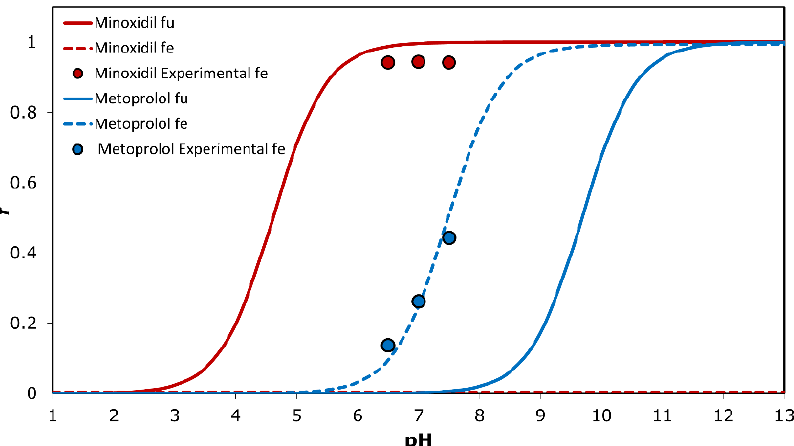
Figure 2. The theoretical fraction unionized ( f u ) and fraction extracted into octanol ( f e ) plots as a function of pH for minoxidil and metoprolol, and experimental buffer ‐ octanol partitioning of the drugs in the three pH values 6.5, 7.0 and 7.5 (n = 6).